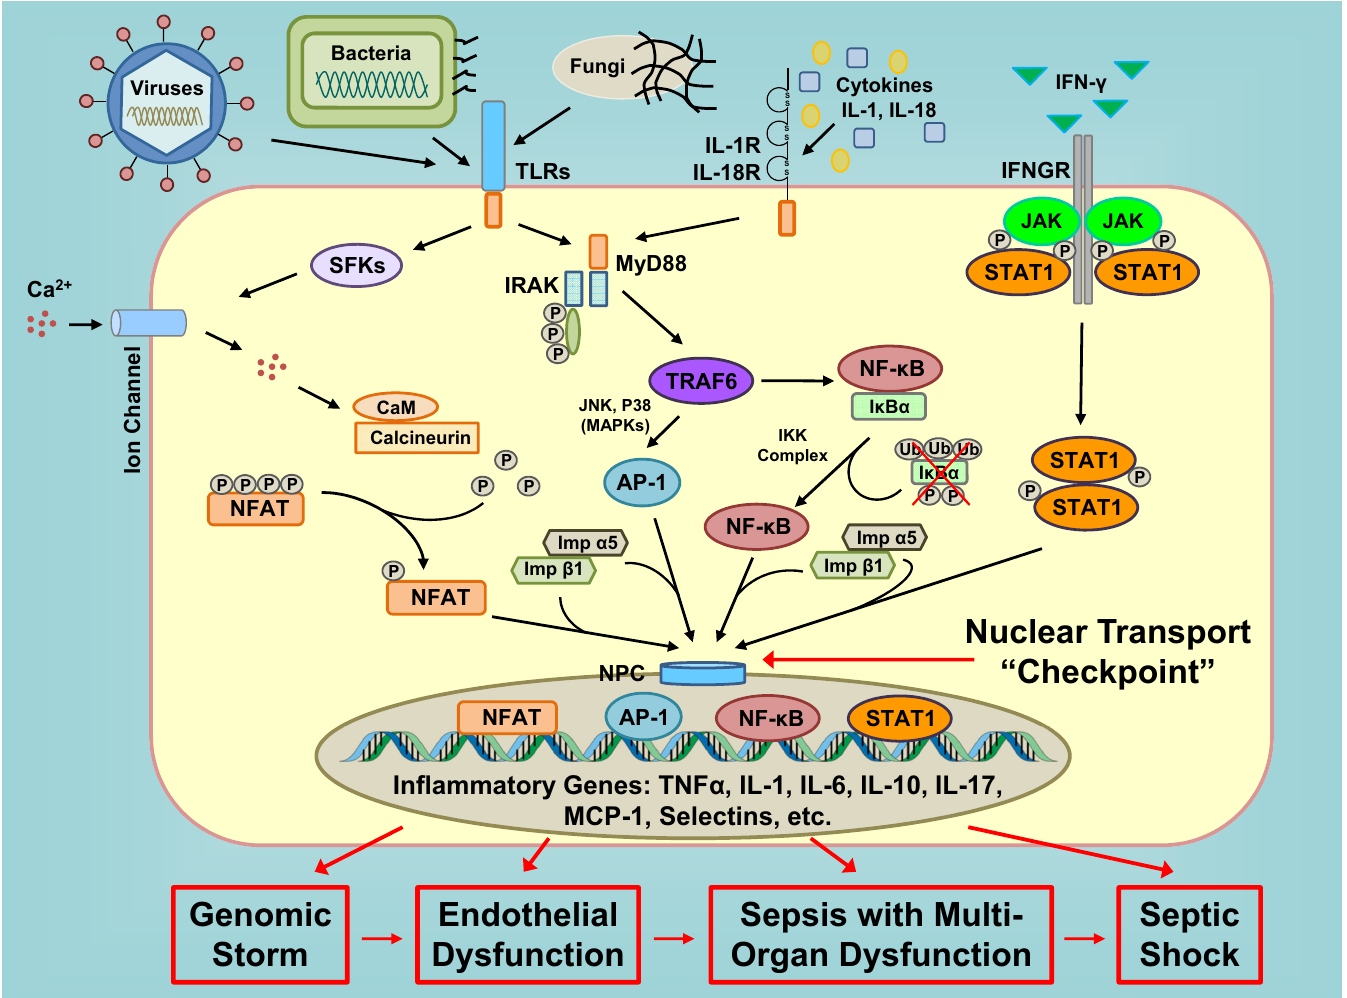
Fig 1. Nuclear transport is a pivotal checkpoint in genomic regulation of microbial inflammation. Inflammatory signalingcascades initiatedby cell responses to microbialvirulencefactors and cytokines culminatein nucleartranslocation of stress-responsive transcriptionfactors (SRTFs) that upregulate inflammatory gene networks. Unchecked, this genomicreprogramming (genomic storm) leads to endothelialdysfunction, multi-organ failure and ultimately fatal shock. Inhibitingnucleartransport at a common “checkpoint” located downstreamof TLRs and cytokine receptors globallysuppressesexpressionof inflammatory genes thereby calmingthe genomicstorm and averting multipleorgan injury. Legend:TLRs (Toll-like receptors); Ca 2+ (calcium ions); IL-1R and IL-18R (interleukin1 and 18 receptors, respectively); IFN- γ (Interferon-gamma); IFNGR (Interferon-gamma receptor); SFKs (Src family of protein tyrosine kinases); MyD88 (Myeloid Differentiation Primary Response88); IRAK (interleukin-1 receptor-associated kinase); JAK (Janus kinase); P (Phosphate group); Ub (Ubiquitin); CaM (Calmodulin); TRAF6 (TNF receptor-associated factor 6); IKK (I kappa B kinase); I κ B α (NF- κ B inhibitoralpha); JNK (c-Jun N-terminal kinase); MAPKs (mitogen-activated protein kinases); NFAT (nuclearfactor of activated T cells); AP-1 (Activator protein 1); NF- κ B (Nuclear factor kappa B); NPC (nuclear pore complex); STAT1 (signal transducer and activator of transcription 1); Imp α 5 (Importin alpha 5); Imp β 1 (Importin beta 1); TNF α (tumor necrosis factor alpha); IL-1, IL-6, IL-10 and IL-17 (interleukin1, 6, 10 and 17, respectively); MCP-1 (Monocyte Chemoattractant